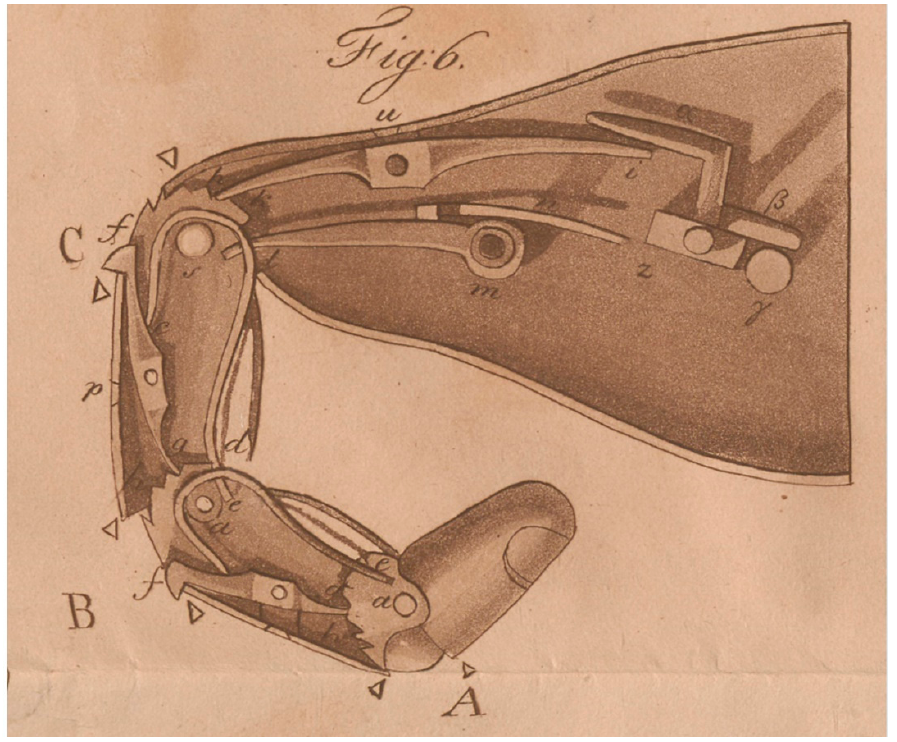
Figure 3. Götz von Berlichingen´s second “Iron Hand”—detail of the finger mechanism: A–C: phalanges. A is hollow and closed on all sides. B and C are hollow but open on one side to accommodate articular vertebrae. a : Pins. The pins unite the phalanges. In addition, the two springs e are placed around them and the pin S . At d , the springs e are provided with an opening ∆ into which the lower part of the spring of the abutting link engages. f , g : Locking lever. p : Hinge head. h :